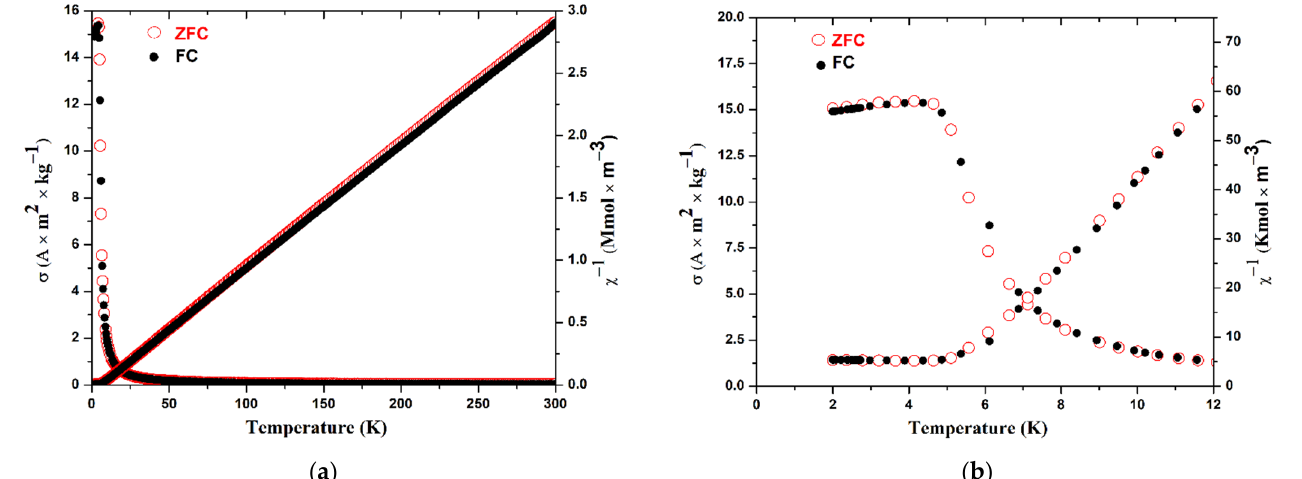
Figure 6. Temperature dependences of specific magnetization σ (left axis) and reciprocal molar susceptibility χ − 1 (right axis) in the temperature range from 2 K to 300 K ( a ) and to 12 K ( b ). Table 6. Magnetic characteristics for EuScCuSe 3 .